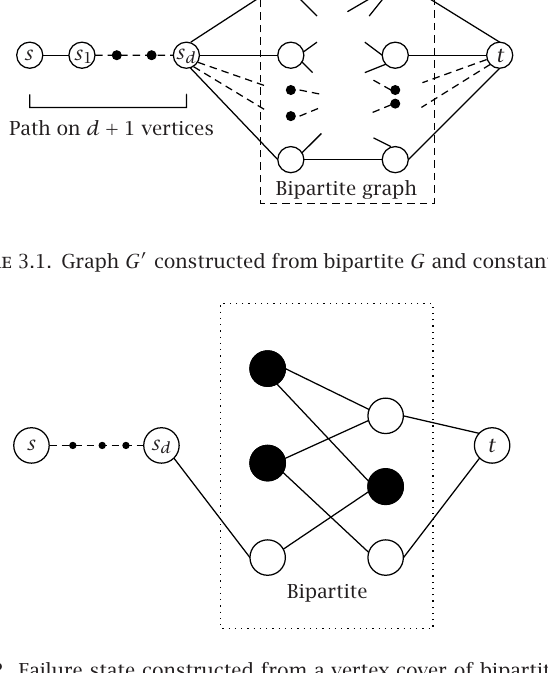
Figure 3.2 . Failure state constructed from a vertex cover of bipartite graph (black vertices represent a vertex